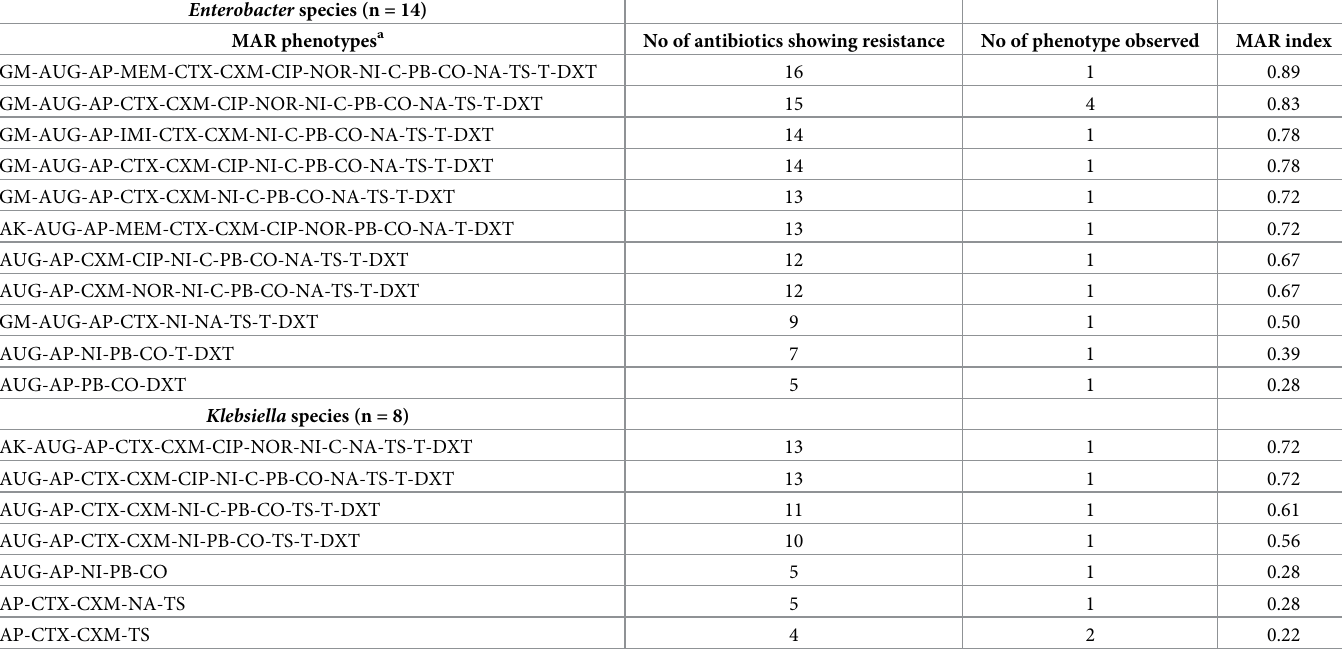
Table 1. MAR phenotypes and MAR indices patterns in Enterobacter spp. and Klebsiella spp. isolated from the rivers.